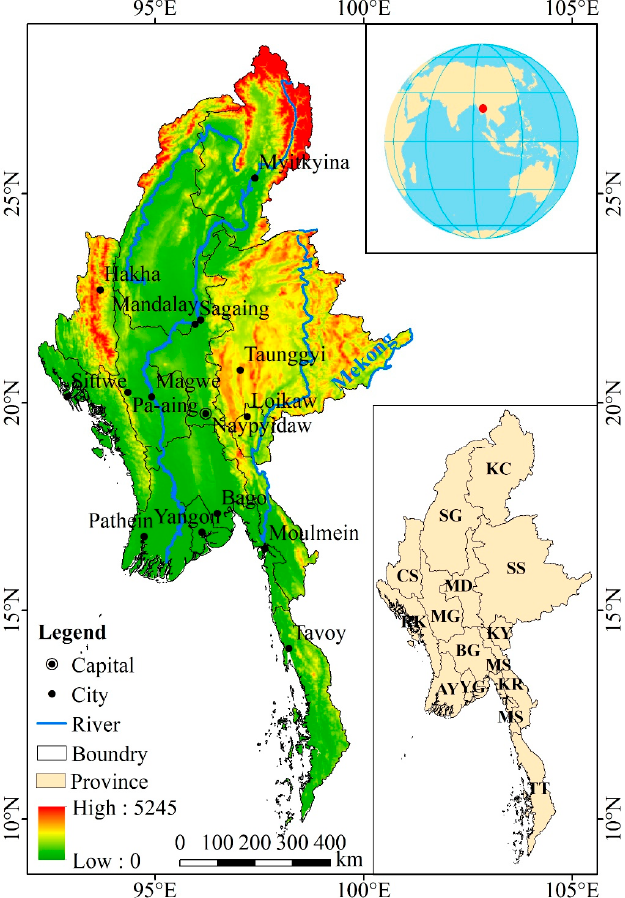
Figure 1. Location and topography map of Myanmar. AY: Ayeyarwady; BG: Bago; CS: Chin State; KC: Kachin State; KR: Karen State: KY: Kayah State; MD: Mandalay; MG: Magway; MS: Mon State; RK: Rakhine; SG: Sagaing; SS: Shan State; TT: Tanintharyi; and YG: Yangon.